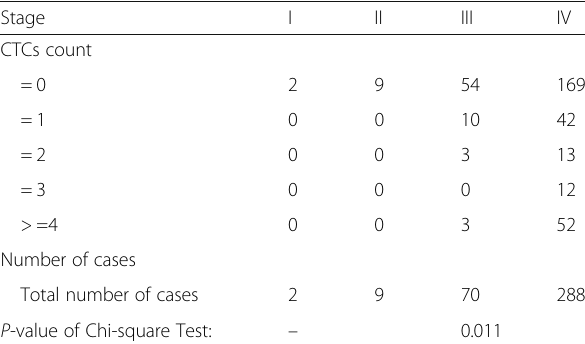
Table 2 Proportions of CTCs in each NPC clinical stage and their comparison